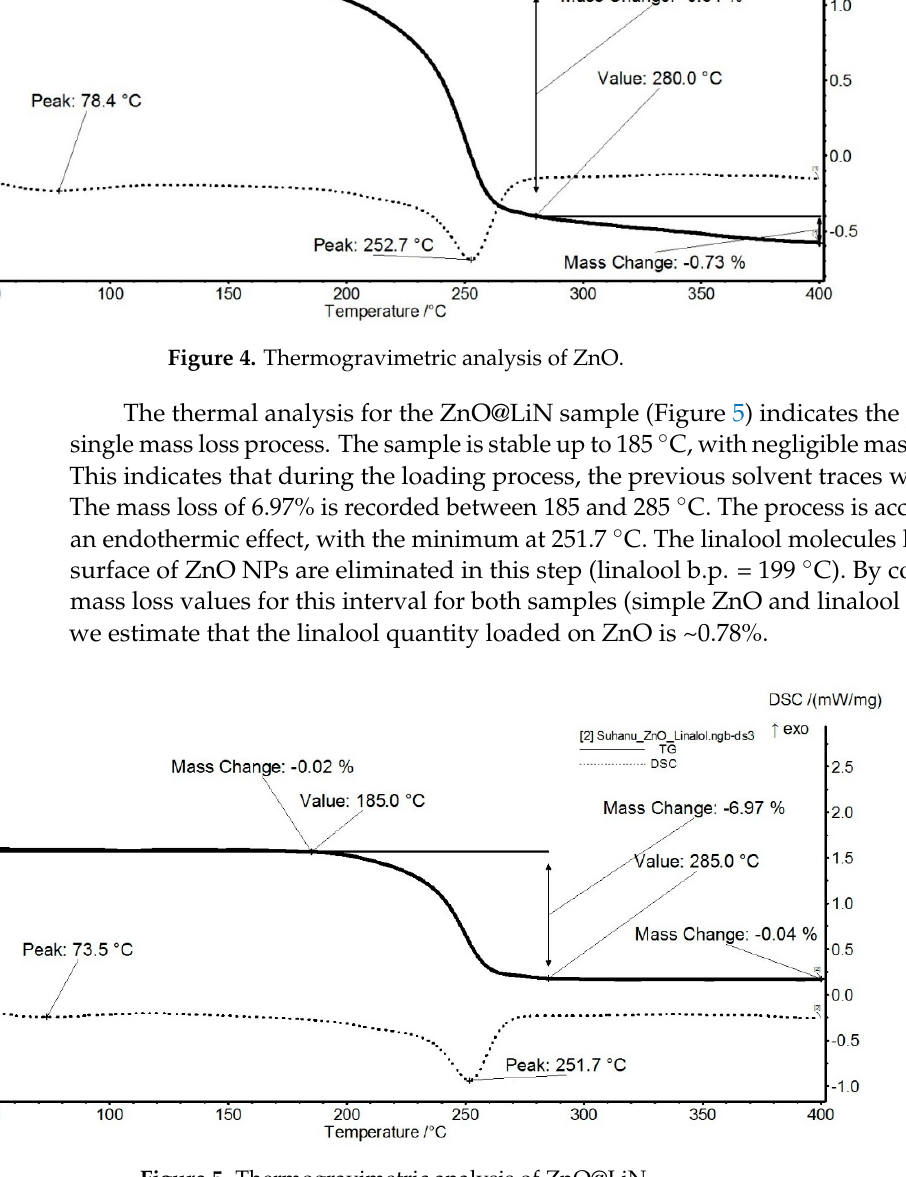
8 of 19 Figure 3. ( a , b ) TEM images; ( c ) HRTEM image; ( d ) SAED pattern of ZnO@LiN nanoparticles; ( e ) histogram of particle size- distribution.